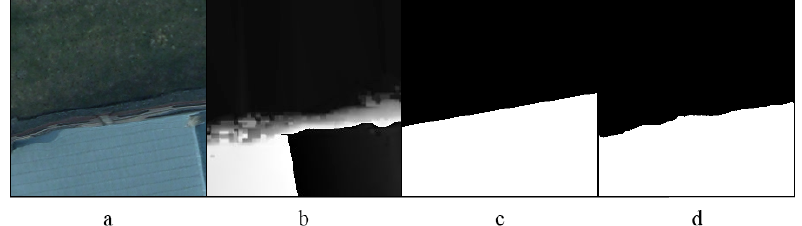
Figure 1. Harmful information in input data. ( a ) RGB patch containing discriminative information. ( b ) DSM patch containing incorrect information. ( c ) Ground truth map. ( d ) Segmentation result. The Att-MFBlock re-weights the RGB and the DSM input so that RGB information is highlighted and the damaged DSM information is